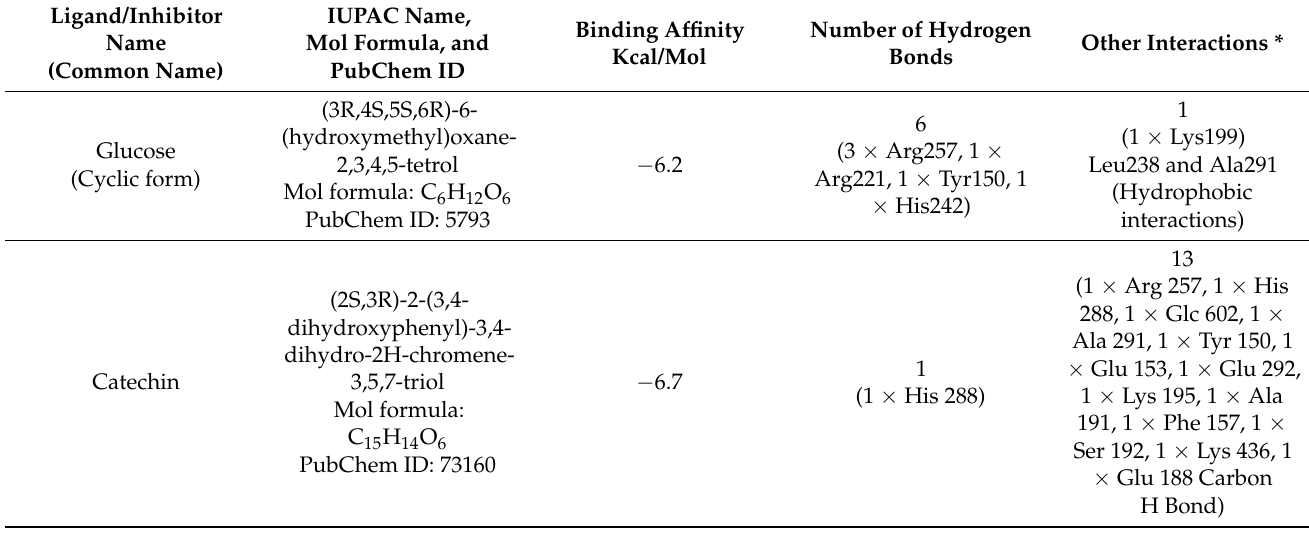
Table 3. Ligands. Common name refers to the compound name used in the